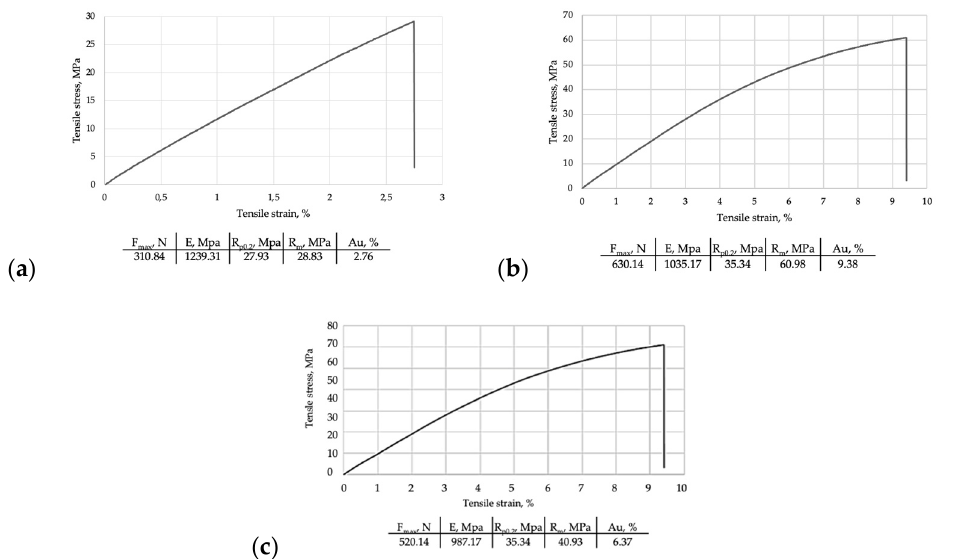
Figure 9. Tensile tests vs. tensile strain diagrams: ( a ) Milled samples; ( b ) 3D printed samples; ( c ) Cured samples.